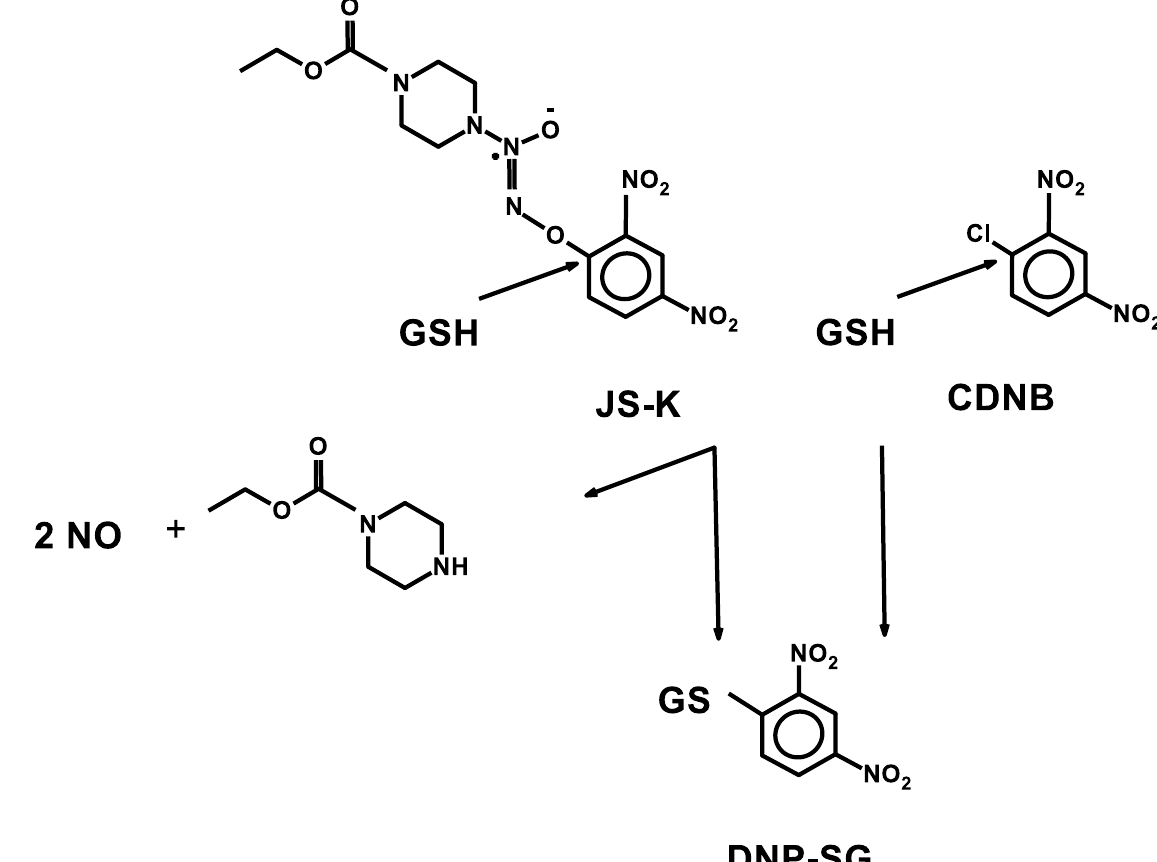
Figure 1. Structural similarities between JS-K (O 2 -(2,4-dinitrophenyl) 1-[(4-ethoxycarbonyl)piperazin-1-yl] diazen-1-ium-1,2-diolate) and CDNB (1-chloro-2,4-dinitrobenzene) and their conjugation with glutathione (GSH). The arrows show the site of nucleophilic attack by GSH leading to the common product S-2,4- dinitrophenylglutathione (DNP-SG), which can be monitored spectrophotometrically at 340 nm. JS-K yields also a second product (not shown), which decomposes into nitric oxide and media containing stock solutions of the purified GSTs were negligible when the enzymes were diluted in the buffer of the JS-K assay. Protein expression. Colonies of Escherichia coli BL21 (DE3) harboring expression clones encoding recom- binant GSTs M4-4, P1-1 and S1-1 were grown overnight in LB medium with 100 µg ml −1 ampicillin, in a shaking incubator at 200 rpm, 37 °C. The culture was diluted 100-fold and grown to A 600 = 0.4, before induction with isopropyl-β-d-thiogalactoside (IPTG) to a final concentration of 0.2 mM. After 3 h the cells were harvested by centrifugation for 15 min at 7000 g . Bacterial cells containing GST M5-5 were cultivated in the manner described above with the exception that they were grown overnight without addition of an inducer. Single colonies of E. coli XL1-blue expressing GSTs A1-1, A2-2, A3-3, M1-1, and M2-2 were grown overnight with shaking in 2TY medium containing 100 µg ml −1 ampicillin at 37 °C. Overnight cultures were then diluted 100-fold into 2TY containing 100 µg ml −1 ampicillin and allowed to grow at 37 °C with shaking until reaching exponential growth. Expression was then induced by addition of 0.2 mM IPTG and the cells were further grown overnight. Cells were harvested by centrifugation at 5000 g for 5 min and the bacterial pellet was resuspended in 0.1 M sodium phosphate buffer, pH 7.0, containing 0.02% (w/v) sodium azide.